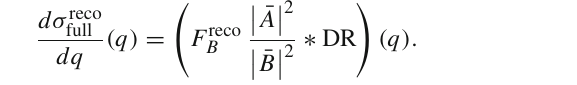
Fig. 12 Fits to reconstructed signal, interference and background dis- tributions, using a convolution of their respective truth-level analytic functions with a DSCB detector resolution parametrisation. The fits are performed over the 300–1000GeV invariant mass window. The free